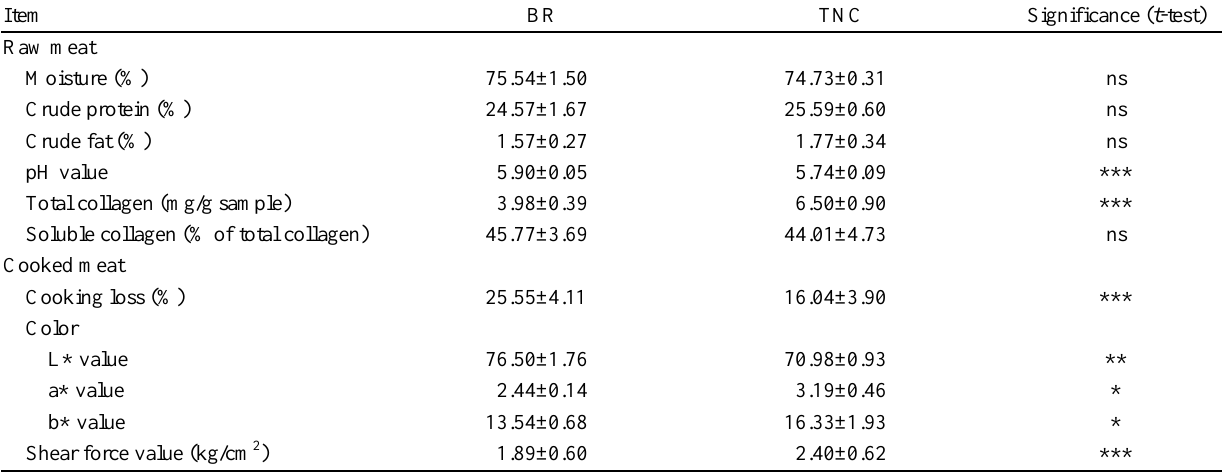
Table 2. Instrumental analyses of broiler (BR) and Taiwan native chicken (TNC) breast